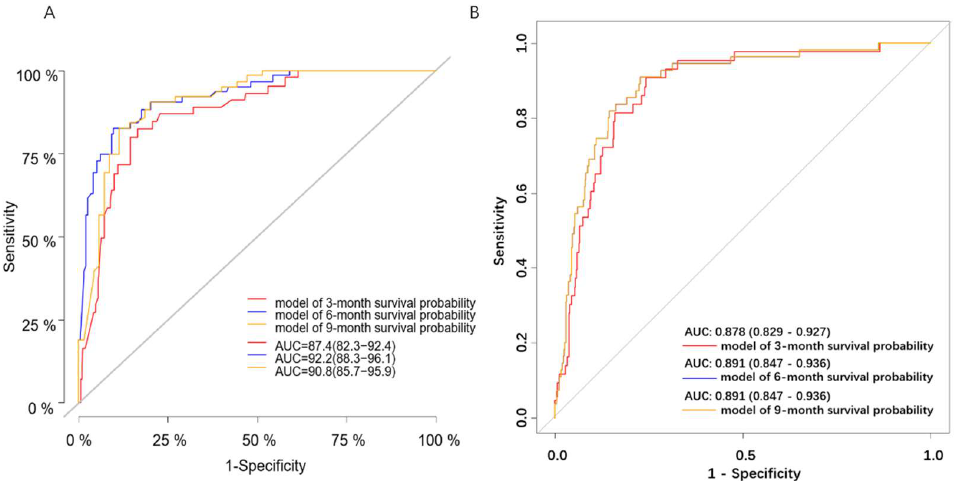
Figure 3. ROC curves of the Cox-PH ( A ) and DeepSurv ( B ) models.